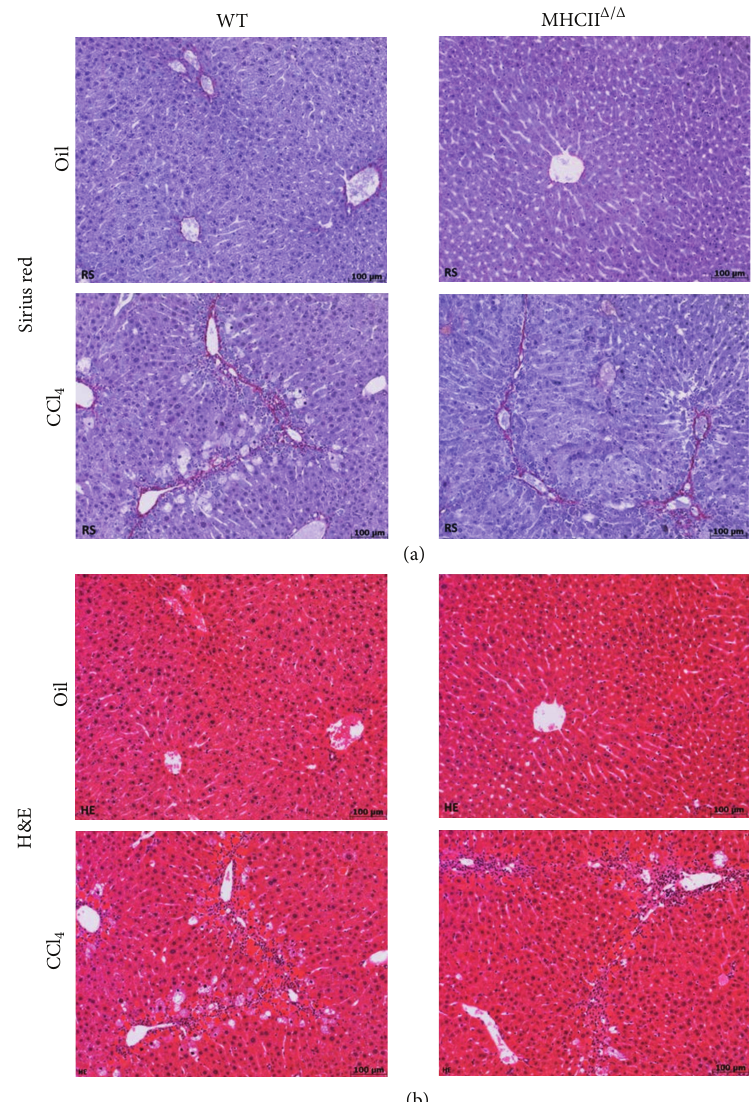
Figure 7: Effect of 4-week CCl 4 treatment on liver histology in wild-type and MHCII Δ/Δ mice. (a) Sirius red staining for collagen. The red staining represents fibrotic area. (b) Hematoxylin and eosin (H&E)